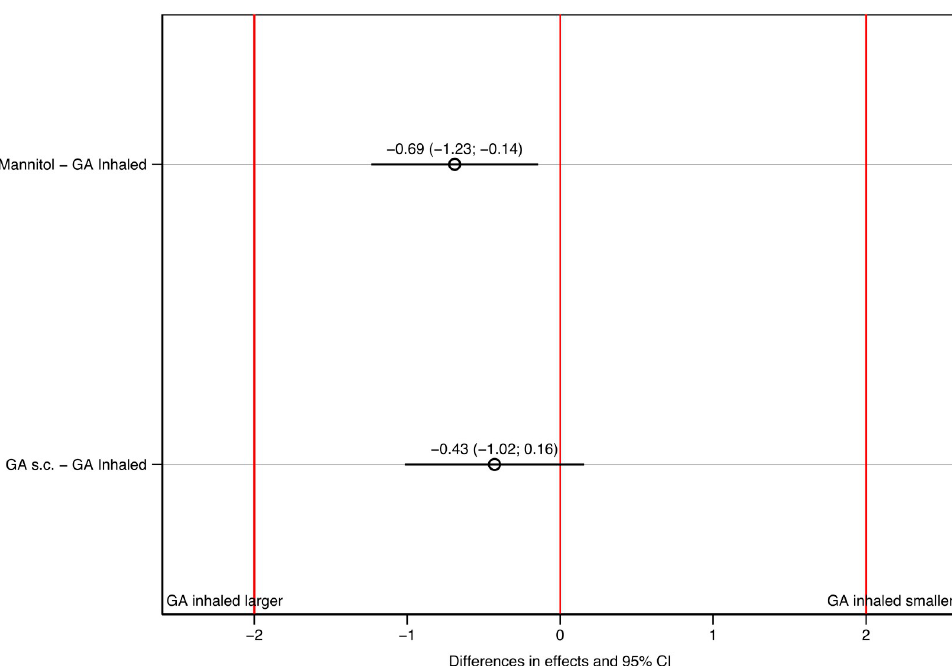
Fig 1. Comparing the effect on P peak of GA inhaled with GA s.c. and mannitol. Although there is a statistically significant larger effect for GA inhaled with respect to the effect of mannitol (confidence interval above red line at 0), both confidence intervals lay within the bounds of the measurement error (-2 and 2 cmH 2 O), red vertical lines), i.e. they are equivalent and clinically insignificant.